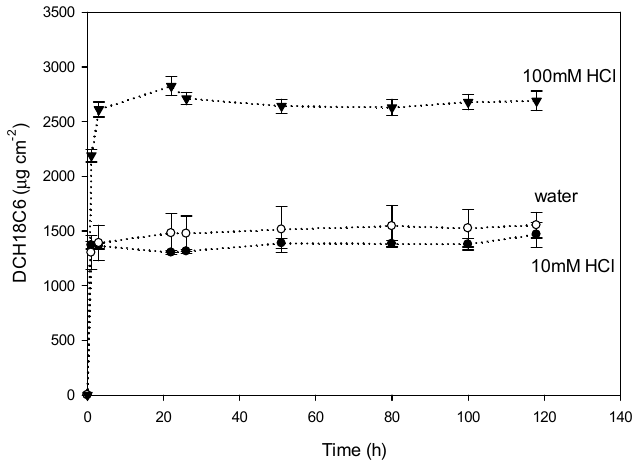
Figure 12. Release of DCH18C6 from PIM in three receiving phases: water, 10 mM HCl and 100 mM HCl.